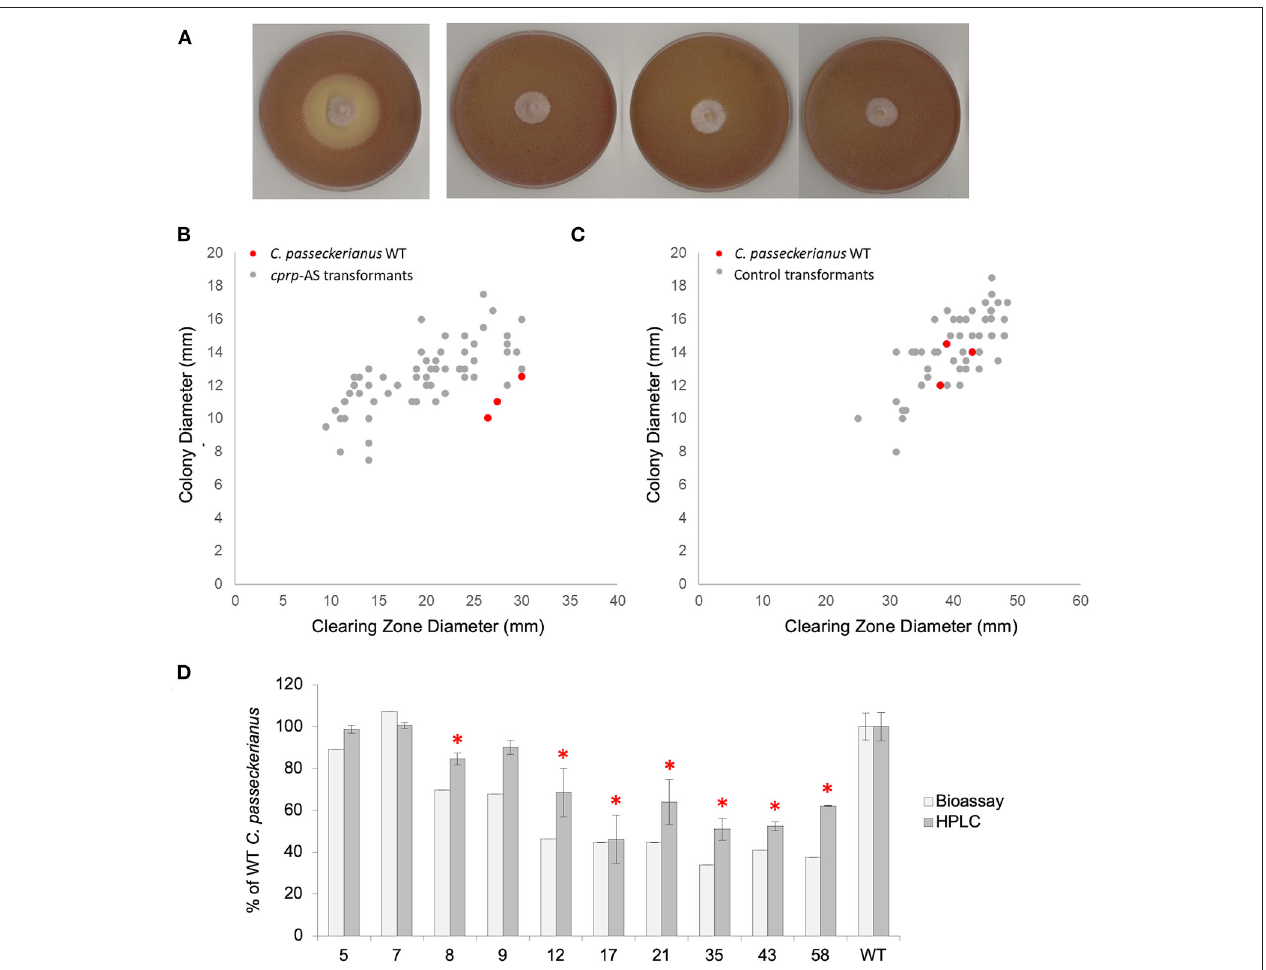
FIGURE 3 | Analysis of pleuromutilin production in a population of cprp -AS (antisense) transformants. (A) Bioassay plates for wild-type C. passeckerianus and cprp -AS transformants 17, 35, and 58 (left to right). (B) Bioassay data for a population of 60 cprp -AS transformants. Full bioassay data for each transformant can be seen in Supplementary Figure 5 . (C) Bioassay data for a population of 53 control transformants containing plasmid pYES-hph-CBXgene. Full bioassay data for each transformant can be seen in Supplementary Figure 5 . (D) HPLC and plate-based analysis of pleuromutilin production for wild-type C. passeckerianus and selected cprp -AS transformants. Transformants 17, 35, and 58 produced no observable clearing zone beyond the edge of the colony; what is seen here is the colony diameter. Error bars represent the standard deviation of triplicate measurements. * denotes HPLC data which was found to be significantly different to the wild-type data (as determined by a two-tailed t -test. See Supplementary Table 1 for P